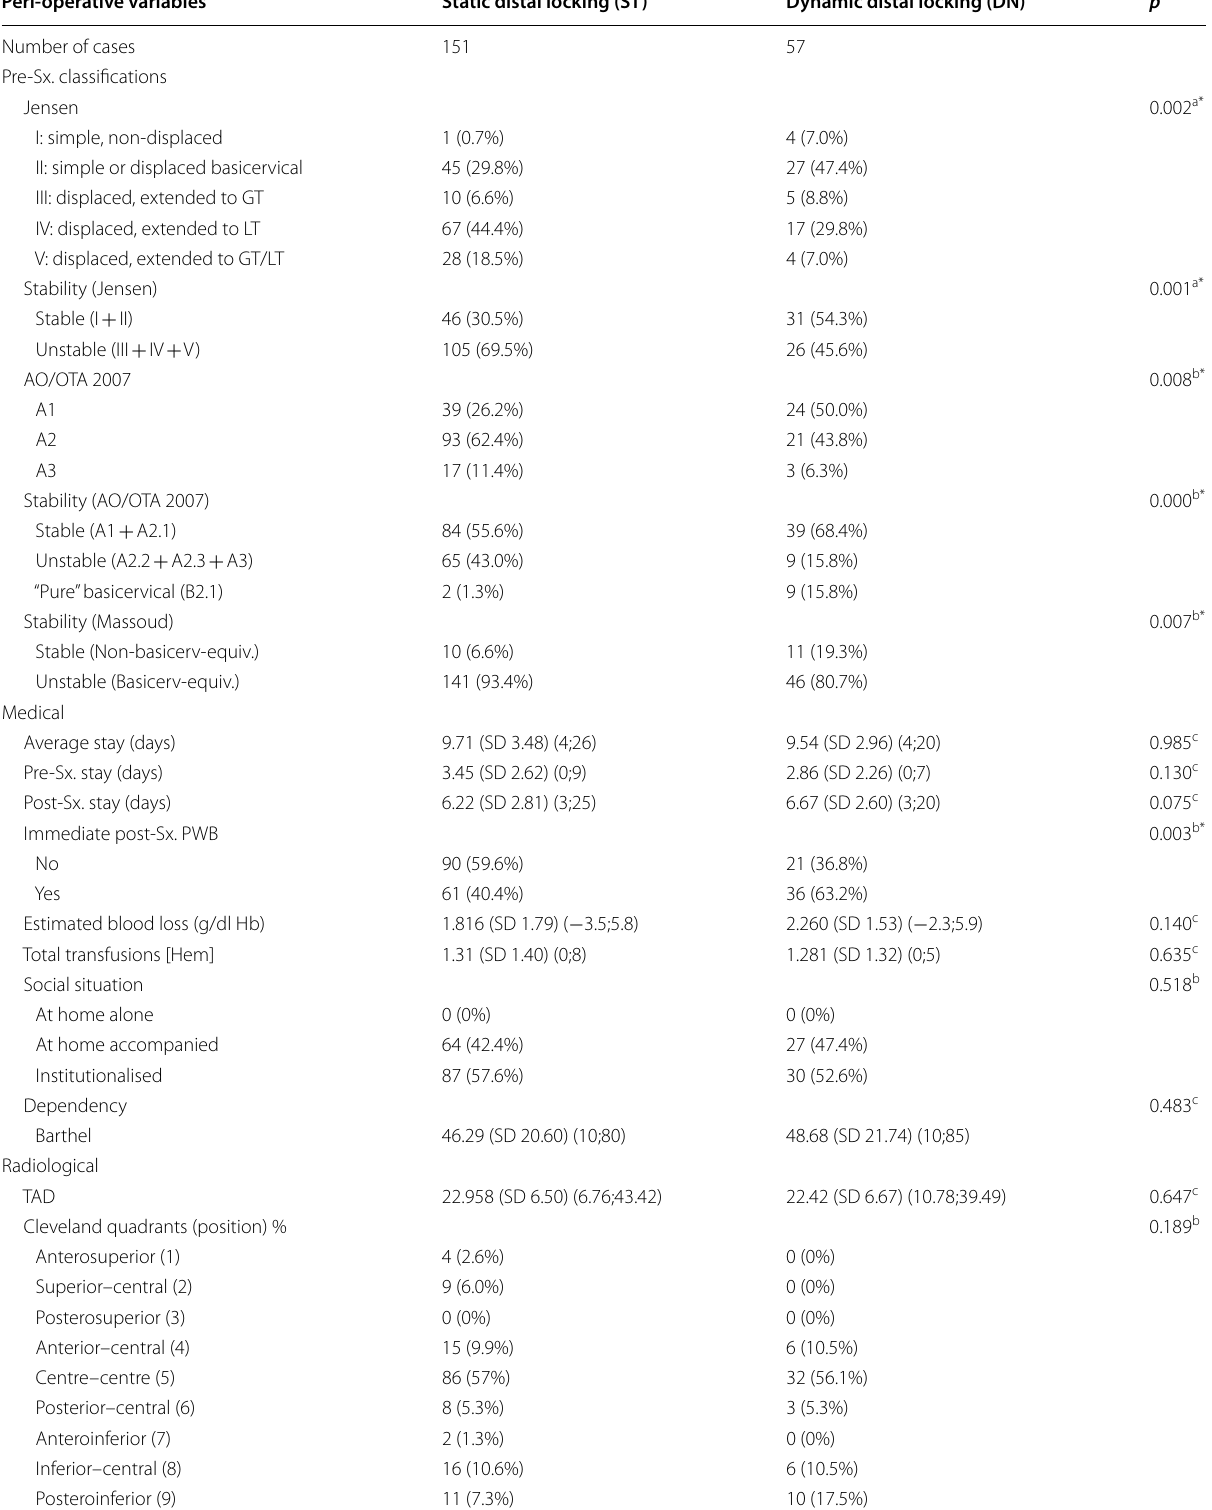
Table 1 Peri‑operative